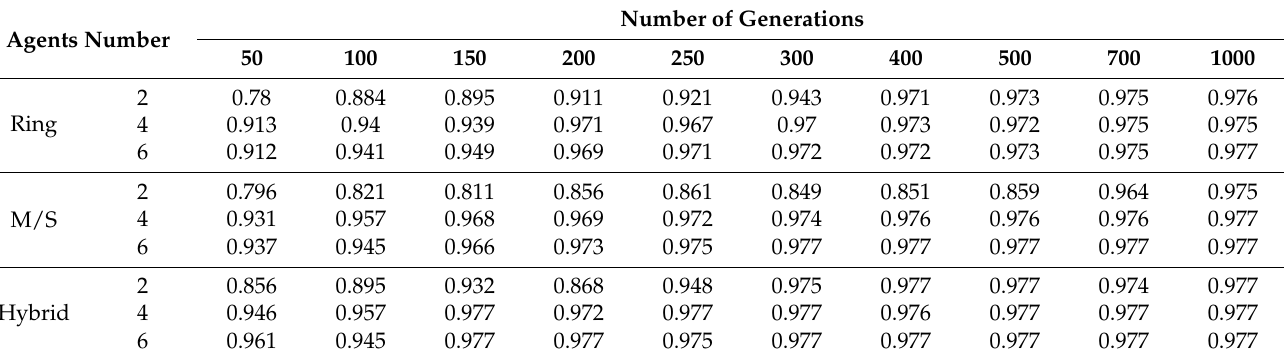
Table 5. NSGA-II using different strategies Agents (Ring, Master/Slave, and Hybrid).